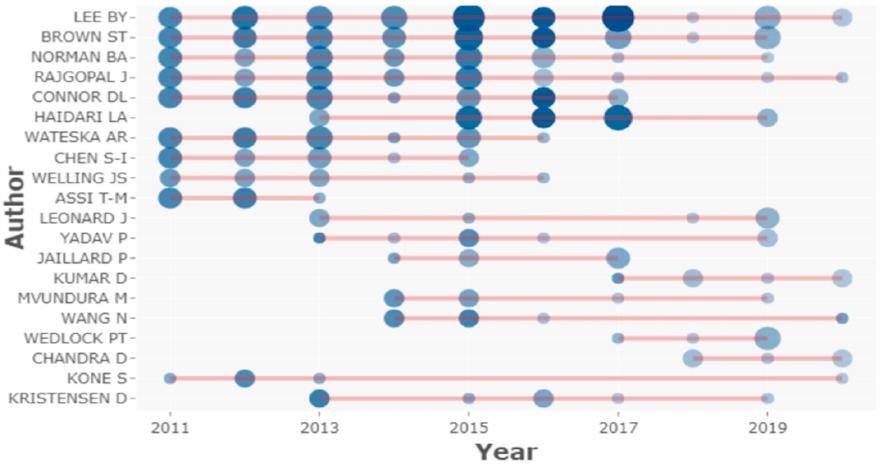
Figure 3. Top 10 Authors and their contribution over the time in the field of VSCM.